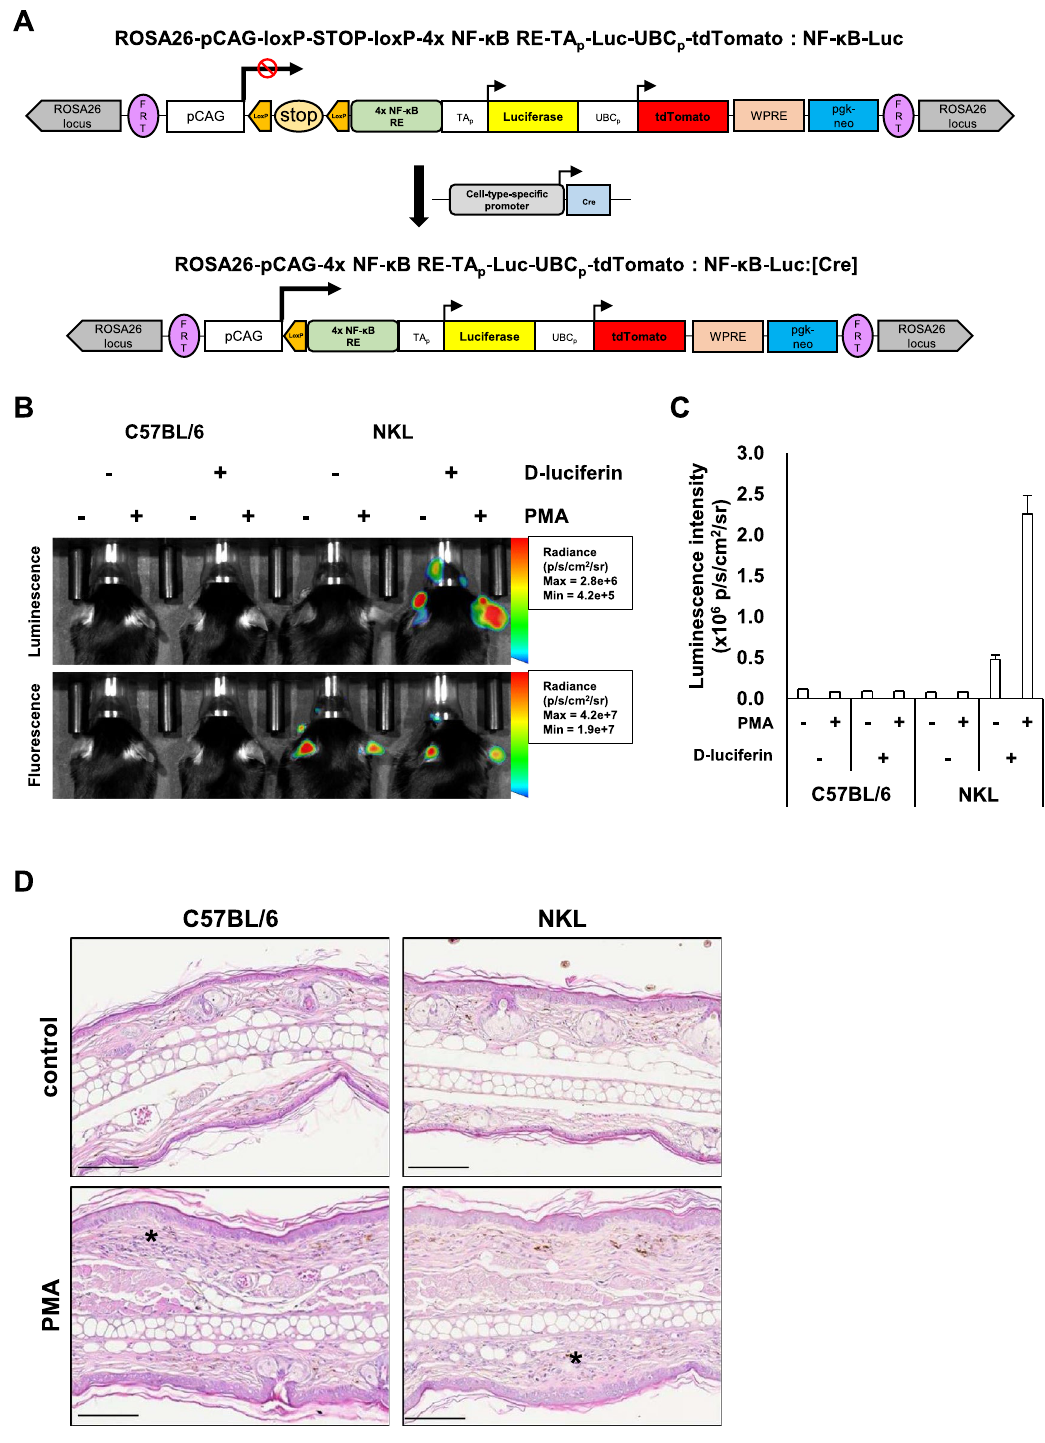
Figure 1. Generation of NF-κB luciferase reporter mice. ( A ) Construct of the NF-κB luciferase reporter gene cassette integrated into the ROSA26 locus. pCAG, synthetic promoter consisting of CMV enhancer fused to the chicken beta-actin promoter; RE (responsive element), four repeats of NF-κB binding sequence; Stop, three repeats of SV40 polyA; TAp, minimal TA promoter (including the TATA box from HSV-tk promoter); WRPE, the woodchuck hepatitis virus posttranscriptional regulatory element; pgk-neo, neomycin-resistant gene driven by pgk promoter. ( B ) Bioluminescence and fluorescence images of C57BL/6 wild-type mice and NF-κB-Luc mice (NKL) in the PMA-induced ear inflammation model. PMA (2 μg) was applied to the right ears, and 6 h later, bioluminescence and fluorescence signals were detected 5 min after D-luciferin (100 µl, 15 mg/ml in PBS) i.p. injection. Radiance ranges of parameters are provided in the figure. ( C ) Mean group luminescence intensities (n = 3 per group). Results are presented as means ± SEMs. ( D ) Representative images of HE stained vehicle or PMA-treated ears (scale bar = 100 μm). Asterisk (*); thickened dermis with infiltrated immune